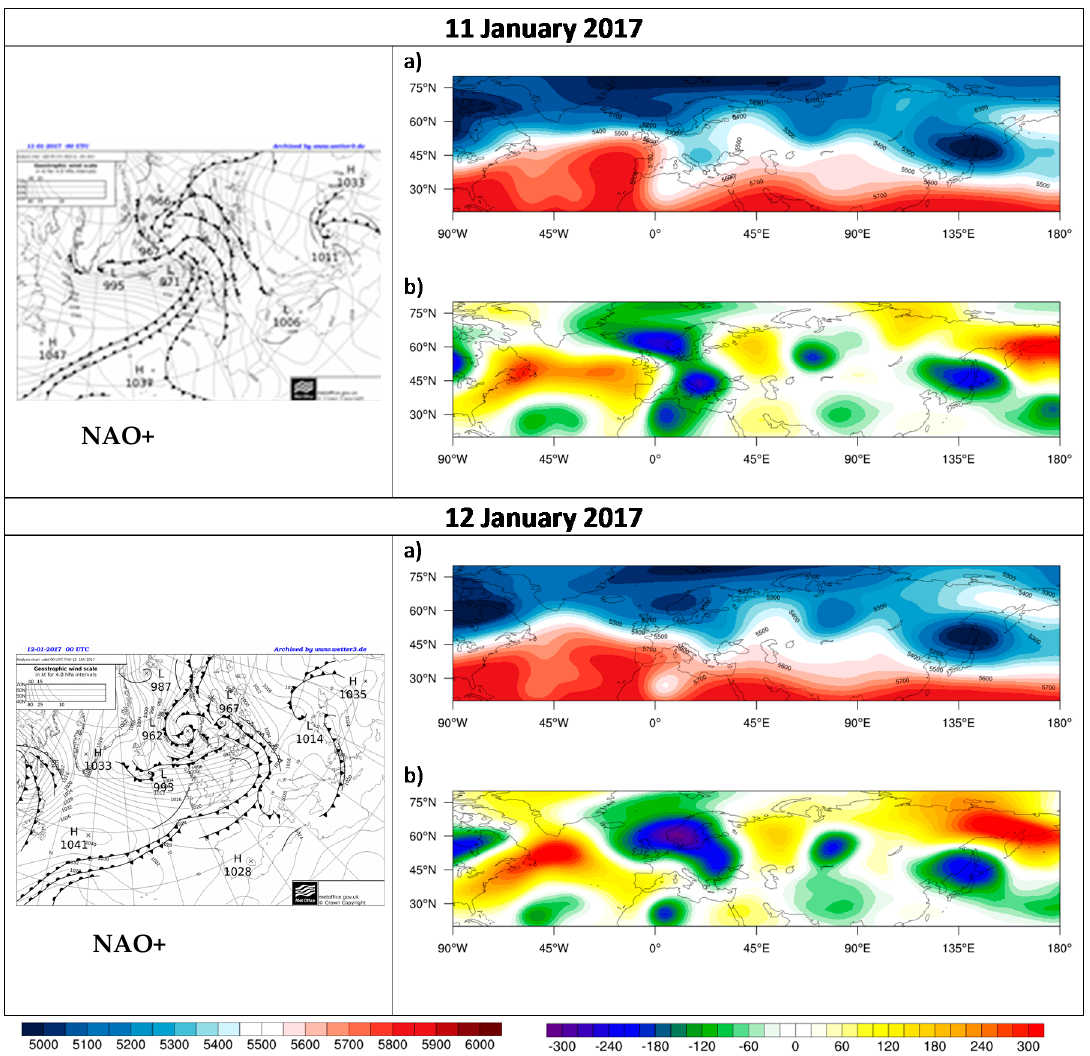
Figure 7. The synoptic pattern for the P+1 stage (11–12 January 2017) and the temporal variation of the NAO. First column: SLP (Met Office; www.wetter3.de); second column: ( a ) geopotential height of 500 hPa and ( b ) anomalies of geopotential heights at 500 hPa level.